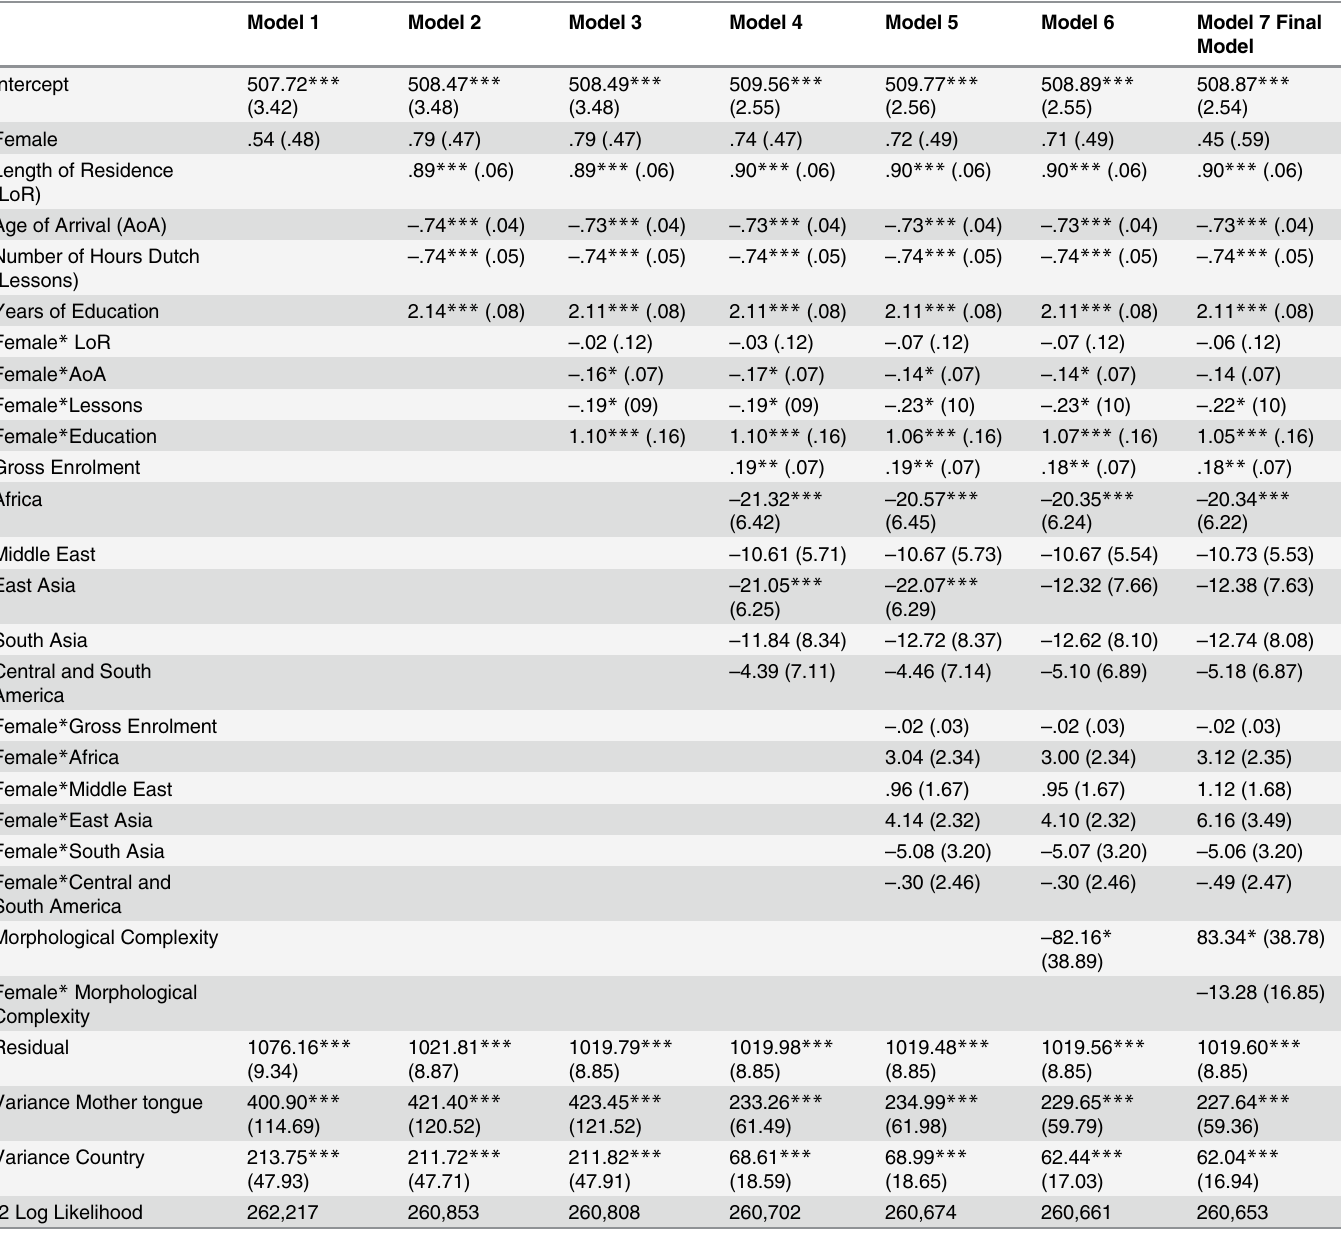
Table 5. Cross-Classified Multilevel Model Parameter Estimations for Measures of the Dutch Listening Proficiency Test (Standard Errors in Paren- theses) per Mother Tongue and Country of